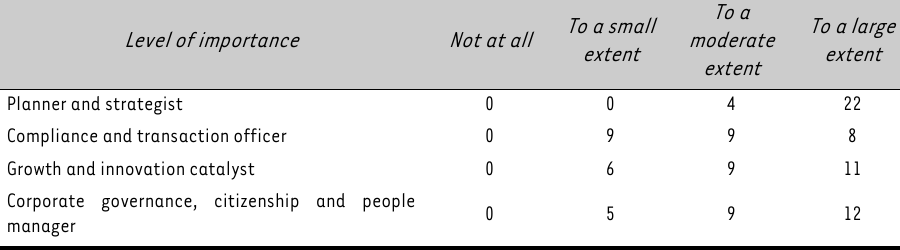
TABLE 12: Relative importance of roles in three years’ time Level of importance Not at